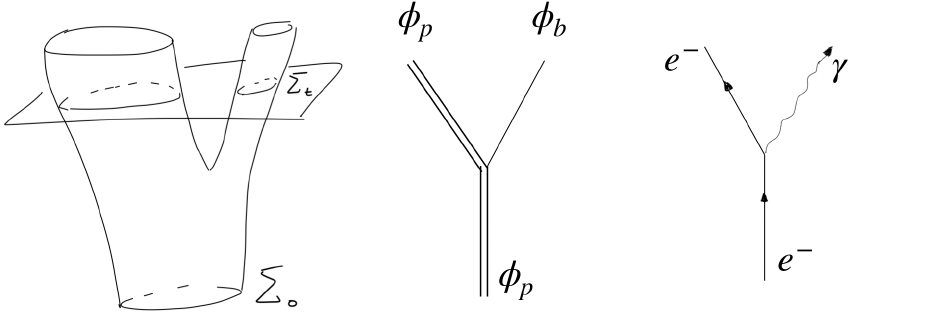
Figure 13. ( Left ) The foliation of a given spacetime can give rise, at some value t 0 , to two disconnected spatial sections. ( Middle ) Schematic representation. ( Right ) Creation of a photon from the scattering of an